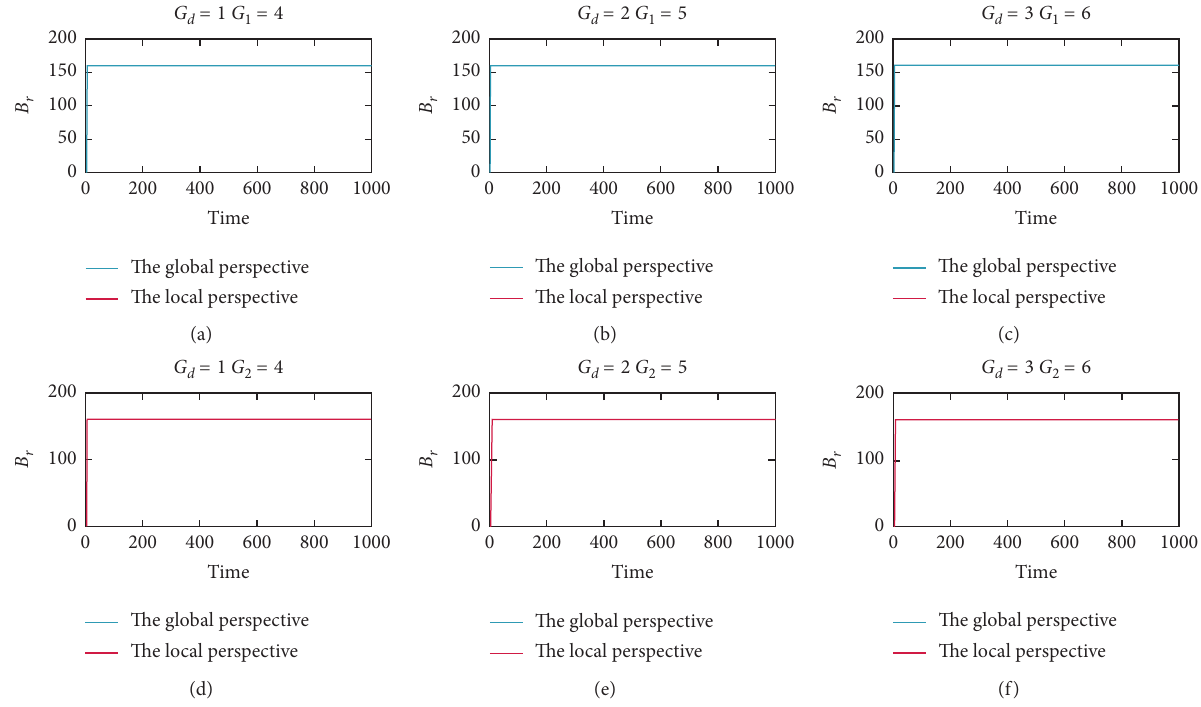
Figure 20: The initial inventory changes of the retailer in a stable state under the scenario of random demand obeying normal distribution from different perspectives.